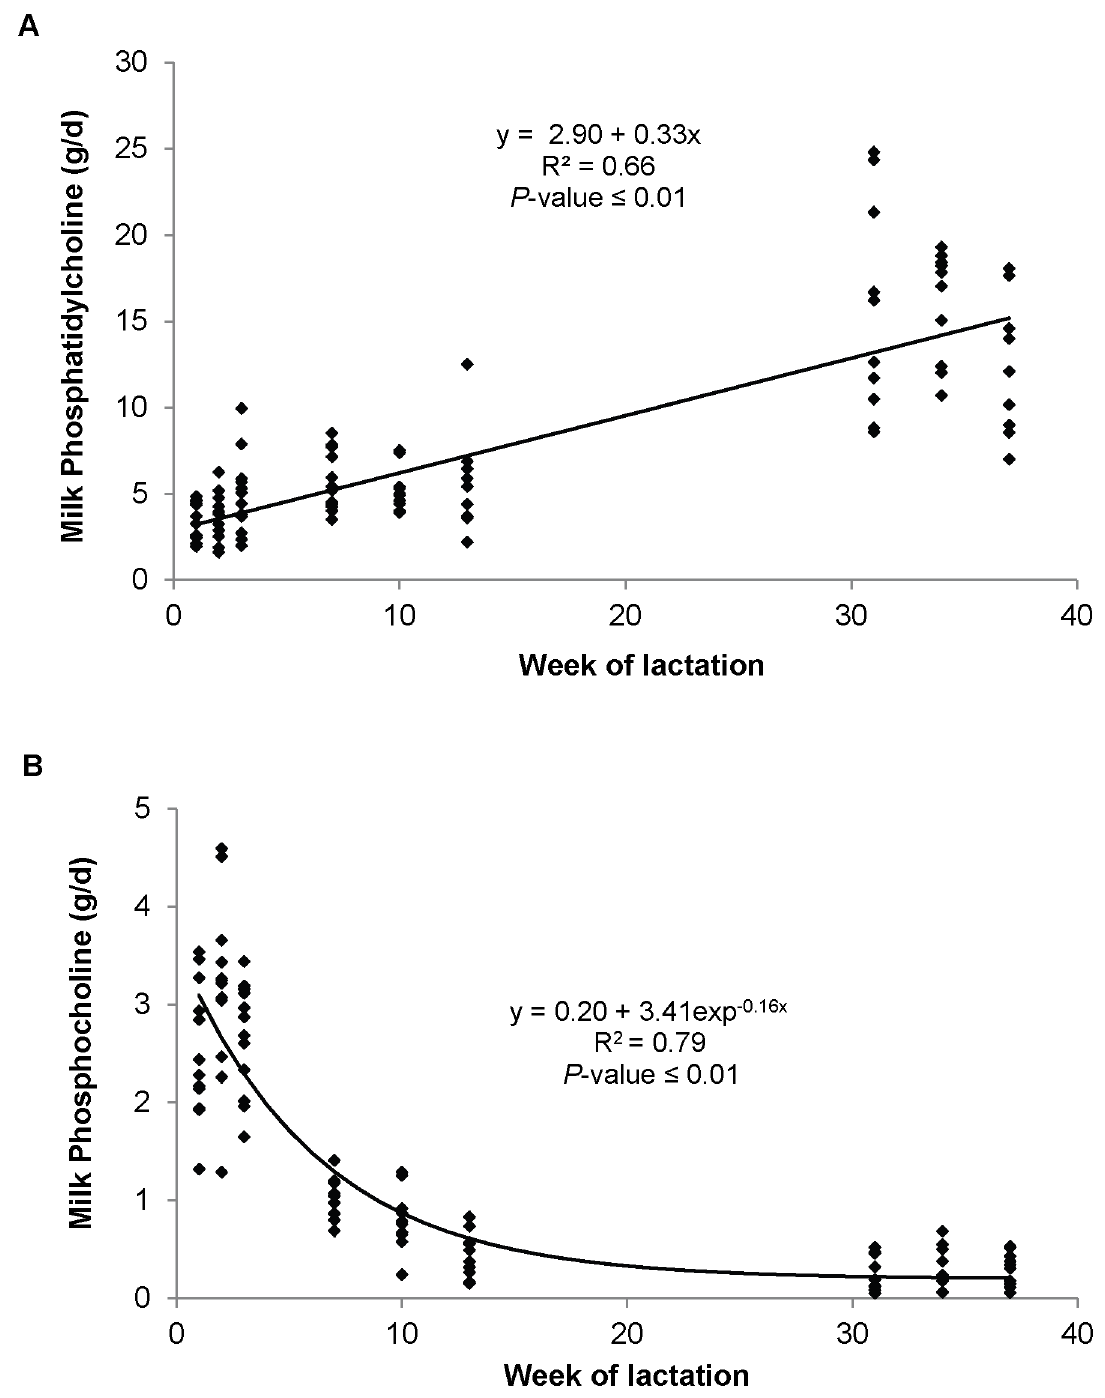
Figure 3. Relationship between week of lactation and milk yields of phosphatidylcholine (A), phosphocholine (B). The standard errors for the intercept and linear terms in (A) were 0.46 and 0.02, respectively. The equation was y=a + b exp 2 cx with the standards errors for the fitted parameters in (B) were 0.106, 0.190, and 0.022 for a, b and c, respectively.